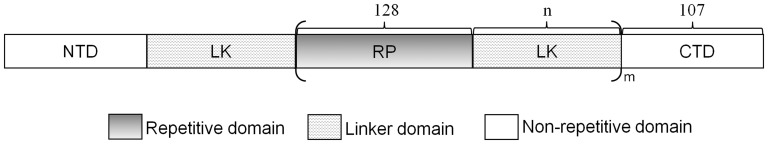
Molecular organization of MiSp.The amino acid (aa) number of each domain is indicated above the corresponding bar, if it is available. The number of aa in LK domain (n) varies from 83–174. The total number of RP and LK in the MiSp sequence is still unknown and is denoted as “m”. The sequences of the NTD and its adjacent LK domain are unknown.